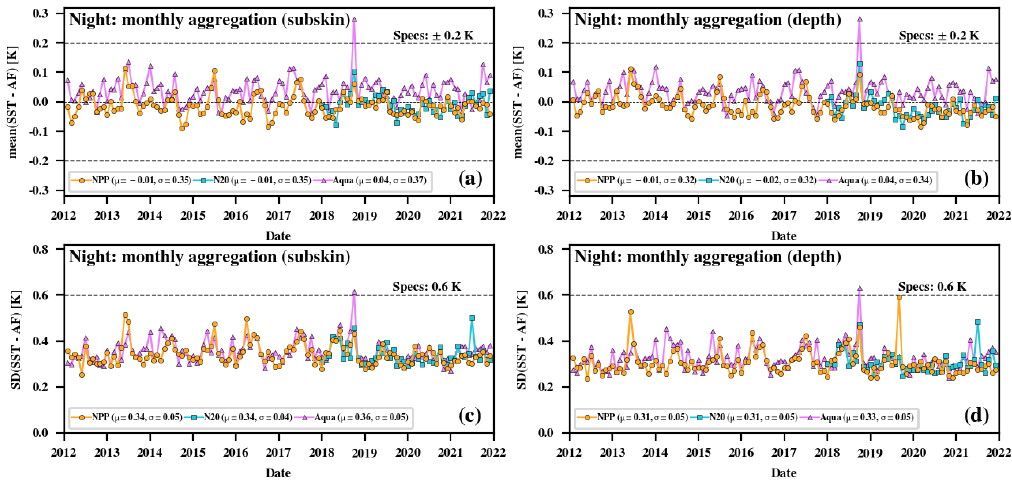
Figure 11. Panels ( a – d ) show the same results as Figure 7 but for monthly aggregated statistics against AFs. Figure 12 shows the corresponding daytime validation statistics versus AFs.